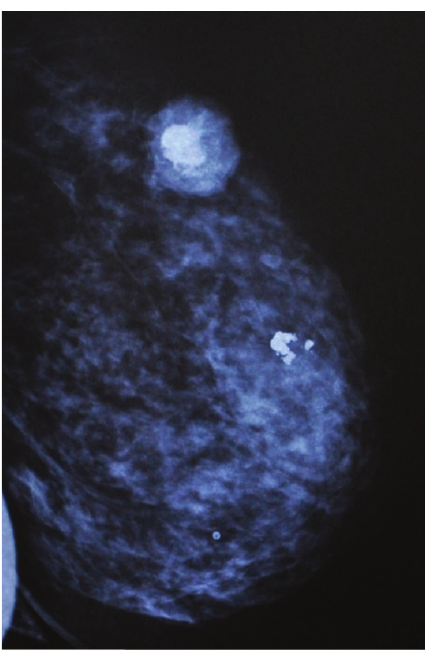
Figure 1: Mammographic features of the lesion.